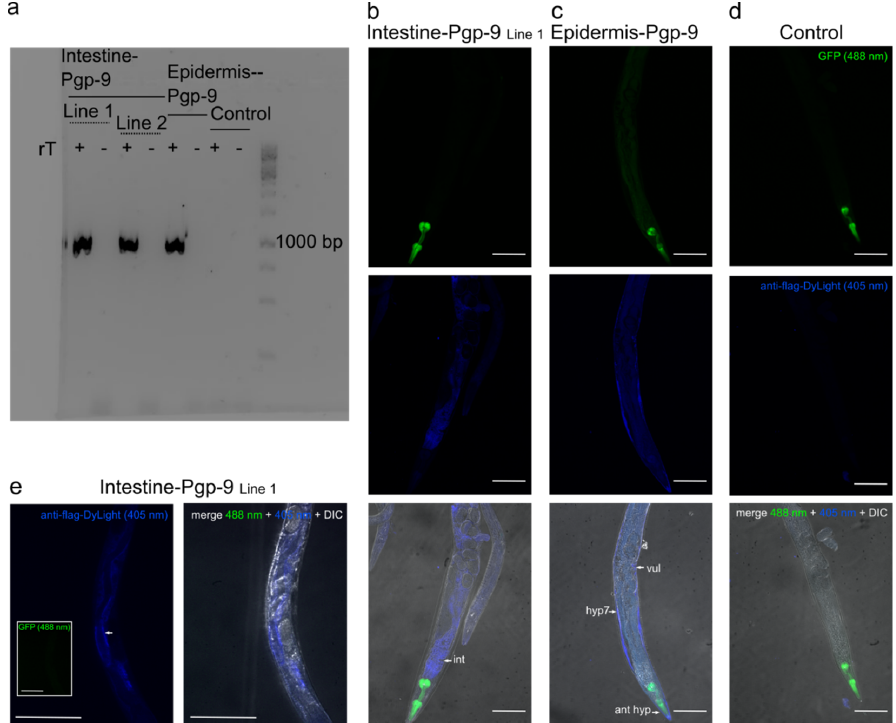
Figure 1. Tissue-specific expression of Pun -PGP-9 in Cel-pgp-9 loss-of-function strain, strain tm830. Verification of transcription and tissue-specific expression. ( a ) Visible bands for all reverse-transcriptase (RT) PCRs on cDNA templates made from whole-worm total RNA, and no bands for no RT controls and the control strain. ( b – e ) Confocal microscope images of tissue-specific expression patterns of fixed, freeze cracked, and immunofluorescence-stained transgenic adult Caenorhabditis elegans (blue lookup table (LUT), 405 nM excitation), pharyngeal GFP expression (green LUT, 488 nm excitation) and merged images (DIC +405 nM + 488 nM). Primary antibodies target the FLAG-tag fused to Pun -PGP-9 and the secondary antibody is conjugated with